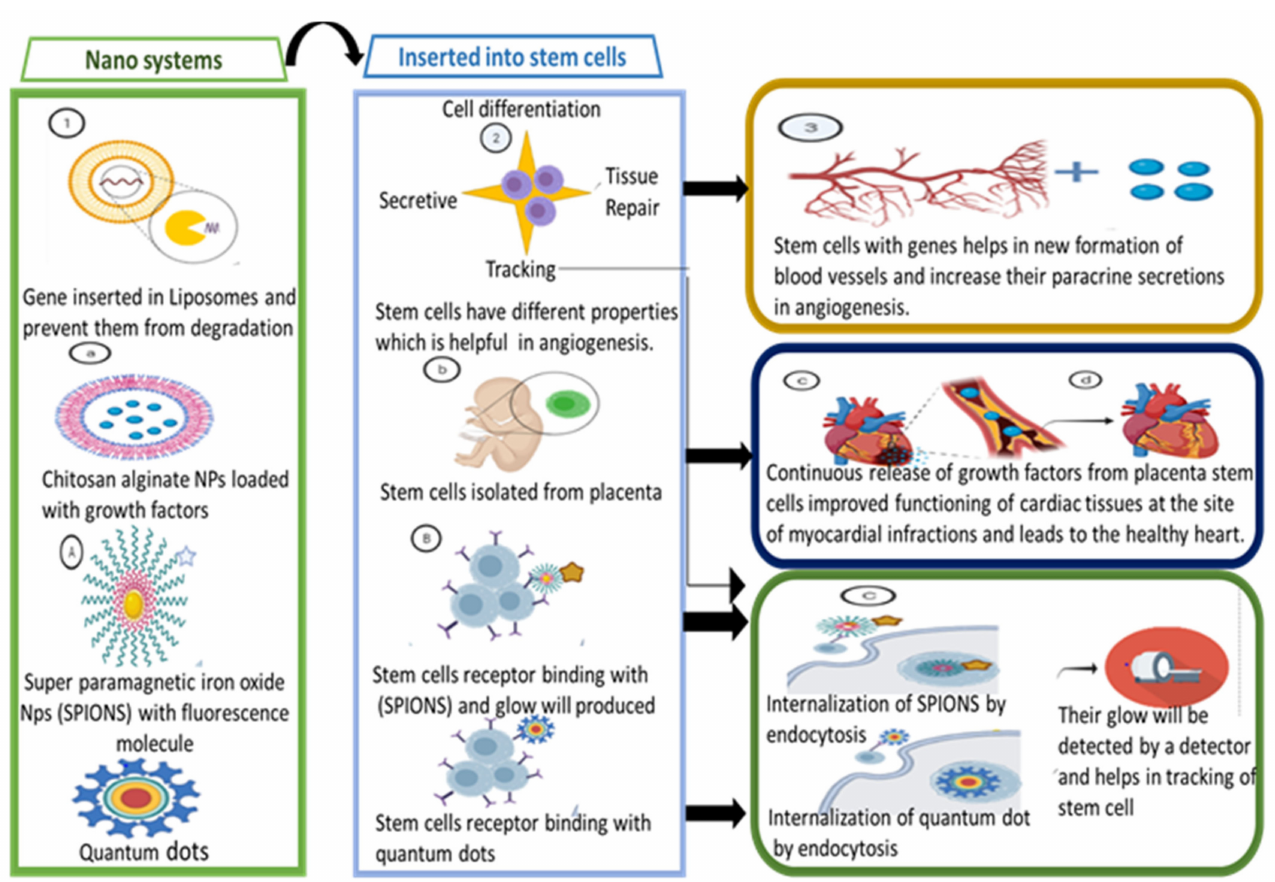
Figure 2. Graphical representation of various nanosystems used in gene